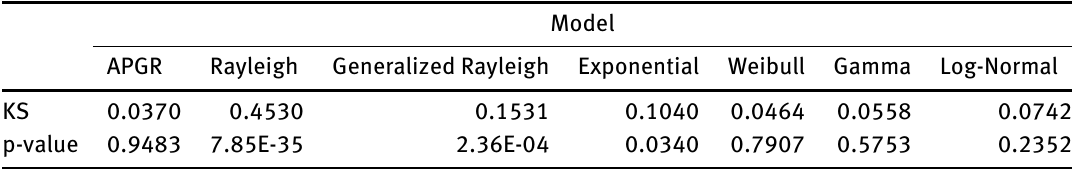
Table 3: KS test results of the possible models for the coal mining disaster data set.